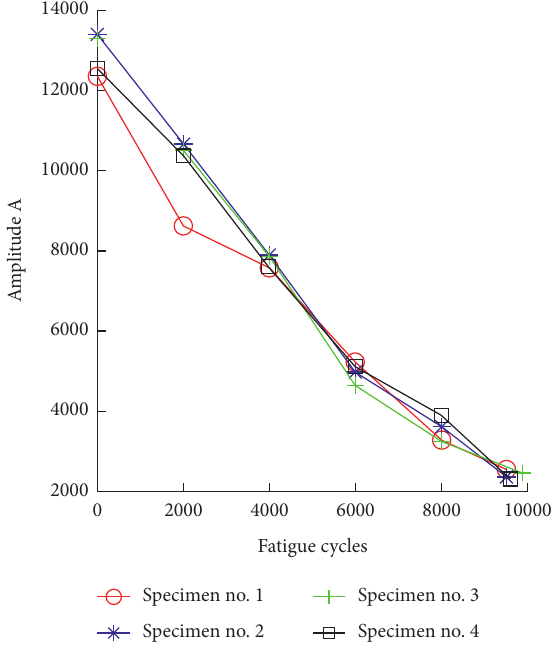
Figure 12: The variation curves of amplitude